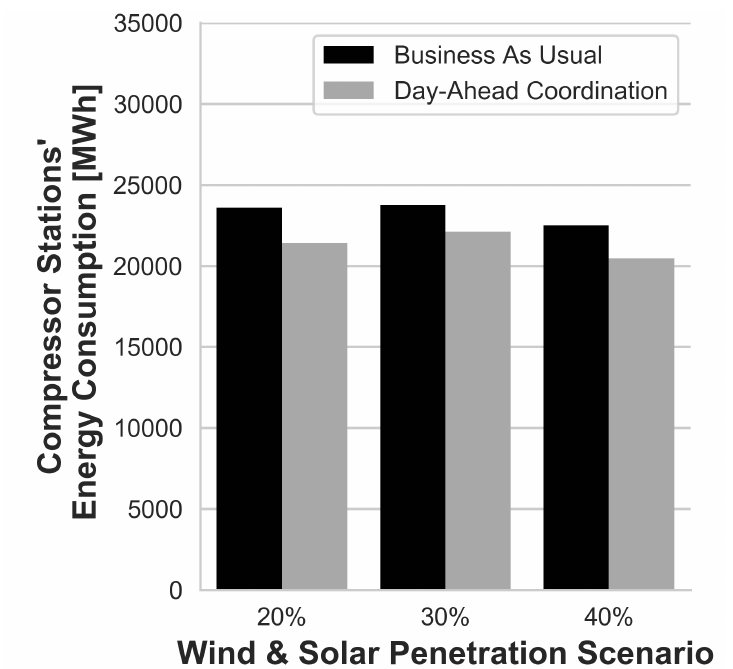
Figure 9. Total energy consumption of gas compressor stations in the Business As Usual and DA Coordination case. Aggregated results for four weeks (one per quarter) with highest system-wide natural gas offtake